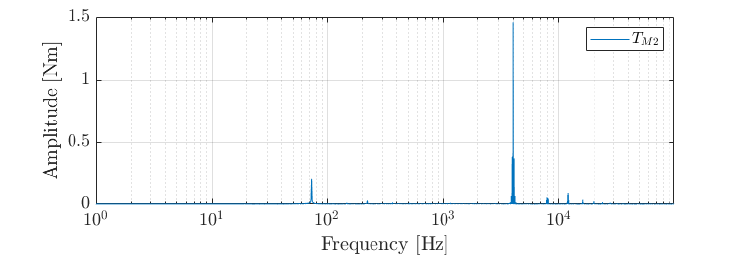
Figure 6. Simulated torque output from motor M2 during the synchronized control modular